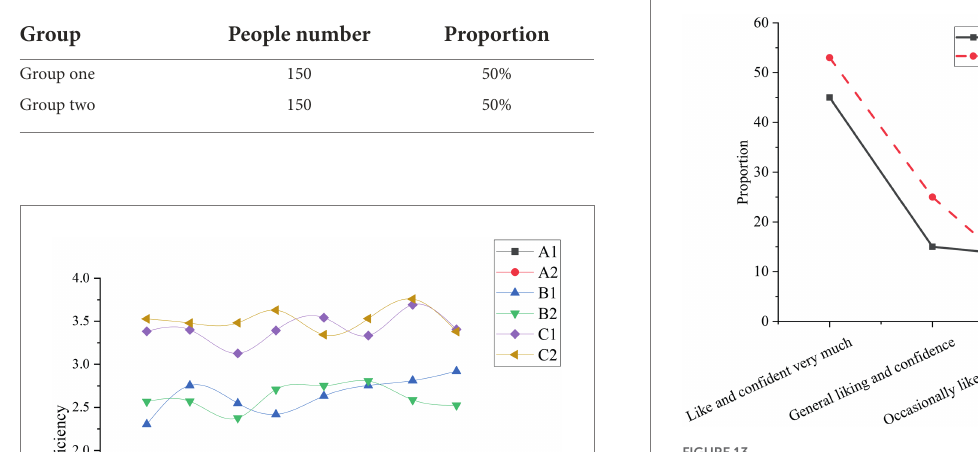
FIGURE 13 Evaluation of college students’ experience of introducing ADL and EC